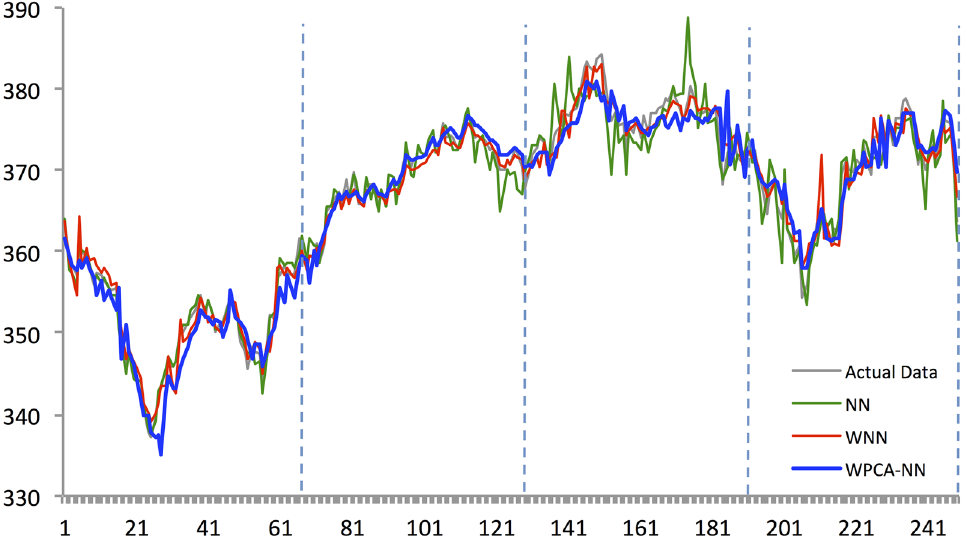
Fig 13. Forecasting results of all models for SiMSCI futures in 2014.